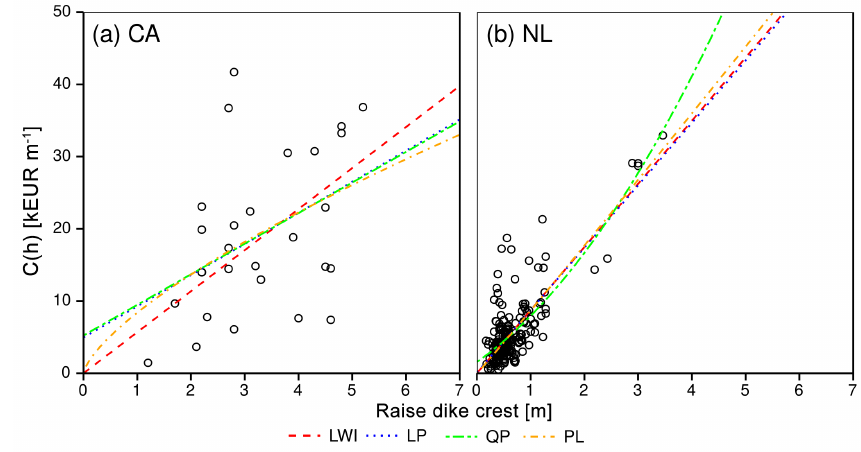
Figure 1. Plot of dike costs versus crest height for all dikes with a linear fit without intercept, LWI (Eq. 1, red dashed line), a linear polynomial fit, LP (Eq. 2, blue dotted line), a quadratic polynomial fit, QP (Eq. 3, green double dashed line), and a power-law fit, PL (Eq. 4, orange dotted dashed line). (a) Twenty-eight Canadian dikes with the obtained fits and (b) 205 dikes in the Netherlands with the obtained fits. The linear and quadratic polynomials collapse in (a) and the linear without intercept with the linear polynomial in (b) ; see main text.